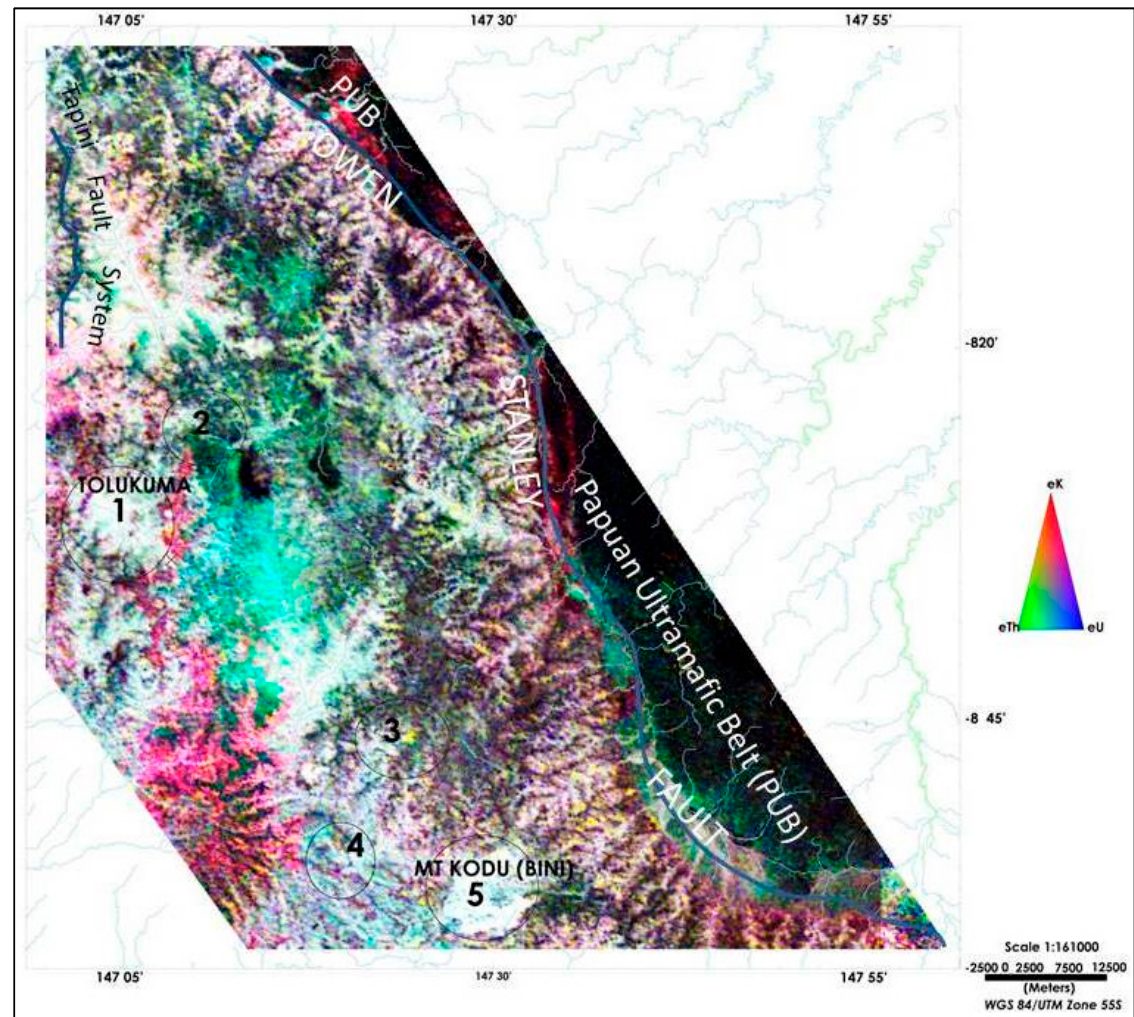
Figure 4. Ternary radiometric image (RGB) produced from combining potassium, thorium, and uranium channels of the airborne radiometric dataset. Circular polygons indicate areas of interest. Numbers 1–5 correspond to magnetic anomalies identied in Figure 3. Anomalies 1 − 5 have similar radiometric response.